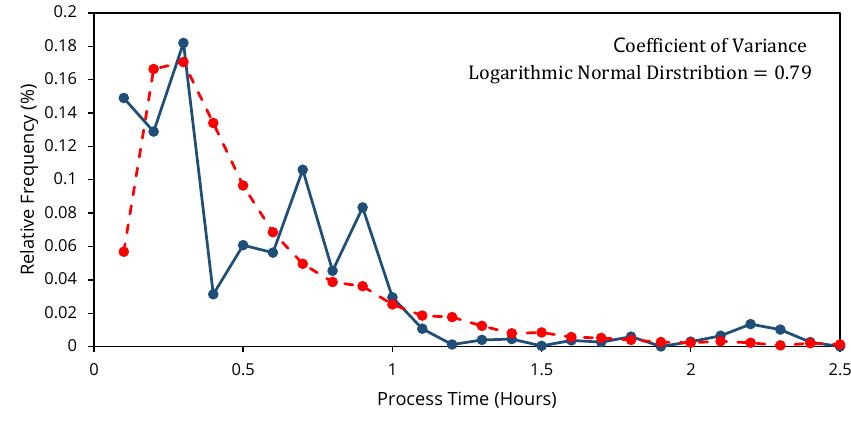
Figure 1. Example of job processing time deviations for a type representative in individual furniture